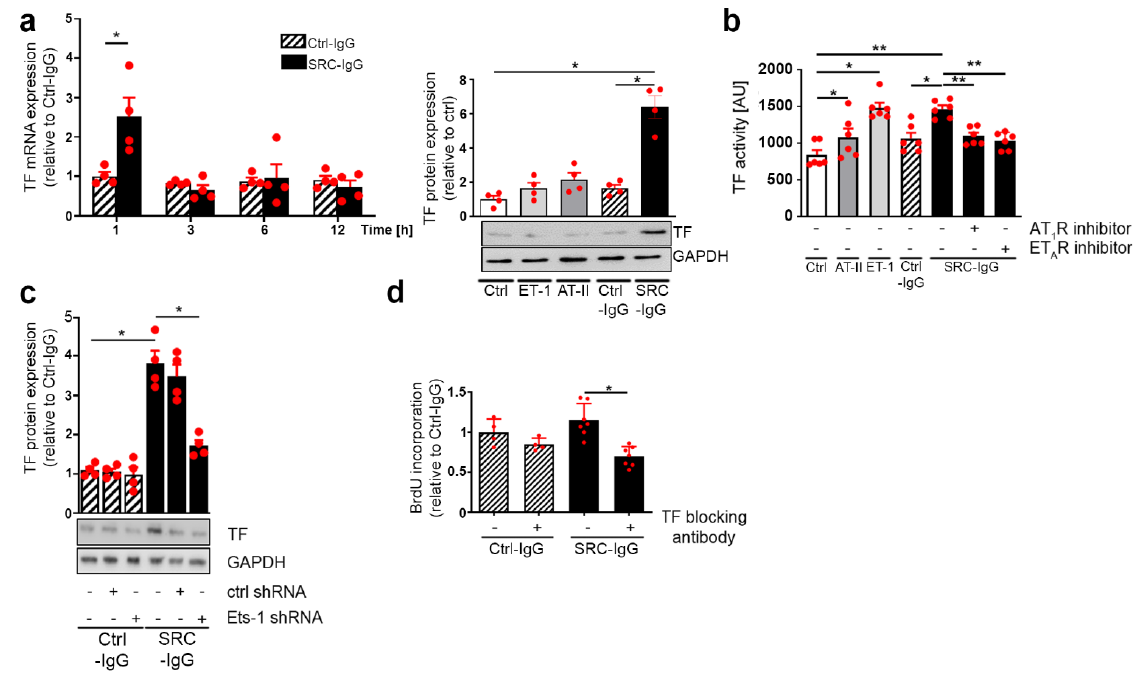
Figure 4. TF involvement in endothelial cell proliferation. Non-stimulated cells (Ctrl) were used as a reference when natural ligands were included, whereas Ctrl-IgG served as a reference when only IgG were used. ( a ) Transcriptional ( left ) and translational analysis ( right ) of TF after endothelial cell stimulation. ( b ) Specific inhibition of AT 1 R/ET A R abolishes TF activity increase. ( c ) Ets-1 knockdown abolishes TF protein synthesis. ( d ) BrdU incorporation shows that pre-incubation with a TF-blocking antibody annihilates endothelial cell proliferation elicited by SRC-IgG. ( a , c ) n = 4, ( d ), 4 ≤ n ≤ 7; representative blots are shown. * p < 0.05, ** p < 0.01.